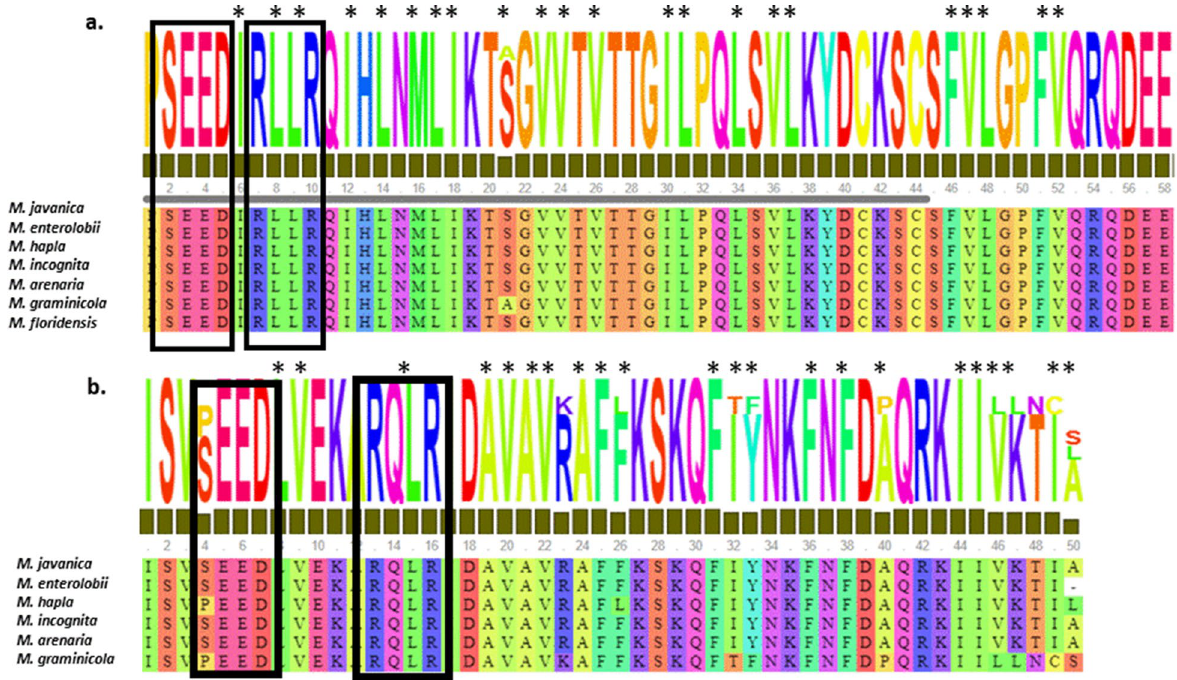
Figure 7. Occurrence of host-translocation RxLR-like motif in MjMCM2 proteins of seven Meloidogyne species. Alignment of ( a ) M. incognita (Minc3s02741g31411) , M. javanica (M.Javanica_Scaff2271g021798) , M. hapla (MhA1_Contig1624.frz3.gene11) , M. arenaria (M.Arenaria_Scaff6715g060087) , M. enterolobii (scaffold23895_cov224.g21986 ), M. graminicola (NXFT01004025.1.10522_g) and M. floridensis, which all possess the first RxLR motif (in black rectangle) close to the N-terminal preceded by the SEED motif (in black rectangle). ( b ) Second RxLR motif (in black rectangle) sequences were found in six Meloidogyne species ( M. floridensis is lacking the C-terminal sequence) . The second RxLR2 was preceded by a SEED motif in most of the RKN species; exceptions were M. hapla and M. graminicola , where it was preceded by a PEED-motif. Asterisks mark hydrophobic amino acids, indicated by WYL or WY